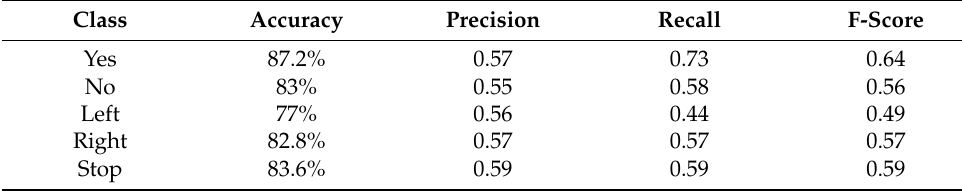
Table 6. Accuracy, precision, recall, and F-score of voice commands.